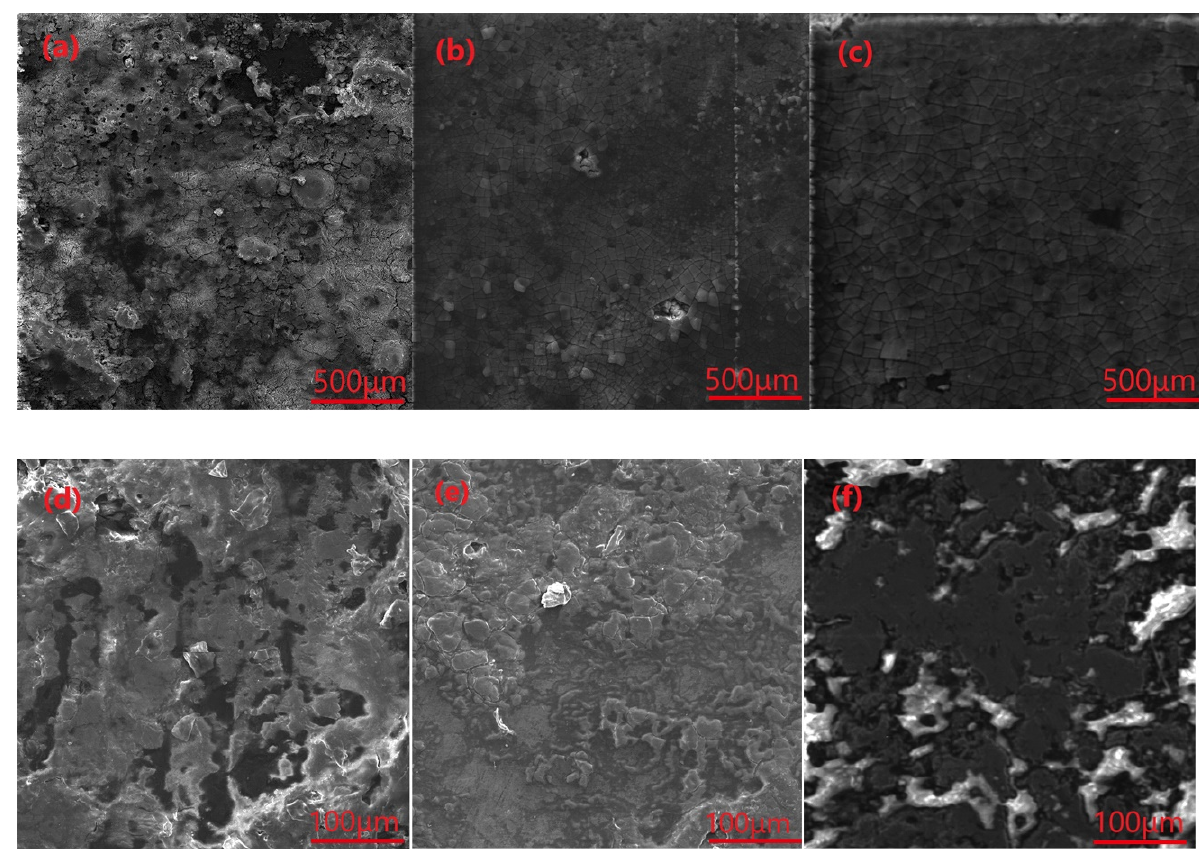
Figure 6. Typical SEM images of samples with different treatments immersed in SBF solution and 5 wt% NaCl aqueous solution: ( a , d ) primal sample; ( b , e ) USRP sample; ( c , f ) USRP + HELL sample.